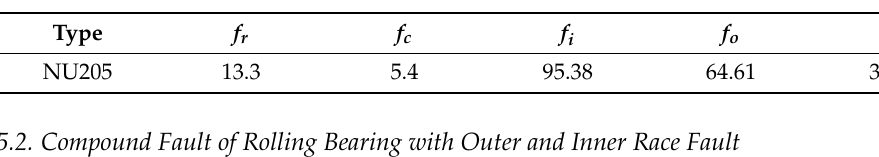
Table 2. The characteristic frequencies of rolling bearing (Hz).